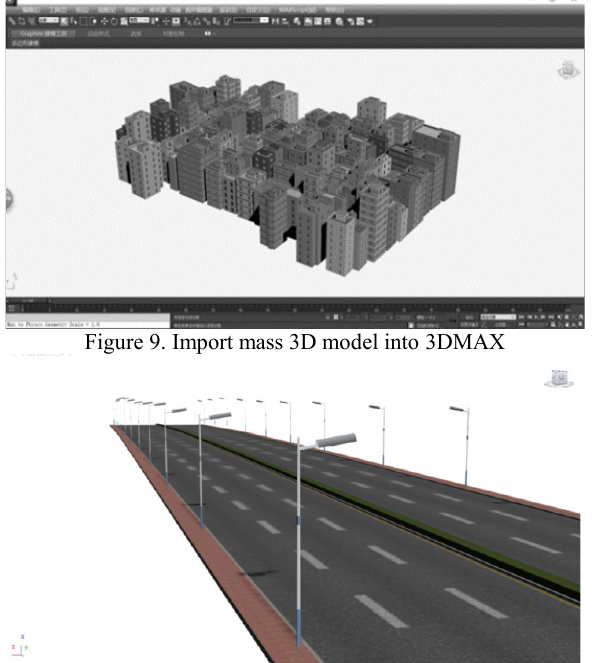
Figure 10. 3DMax batch import 3D streetlamp model of Dongfeng